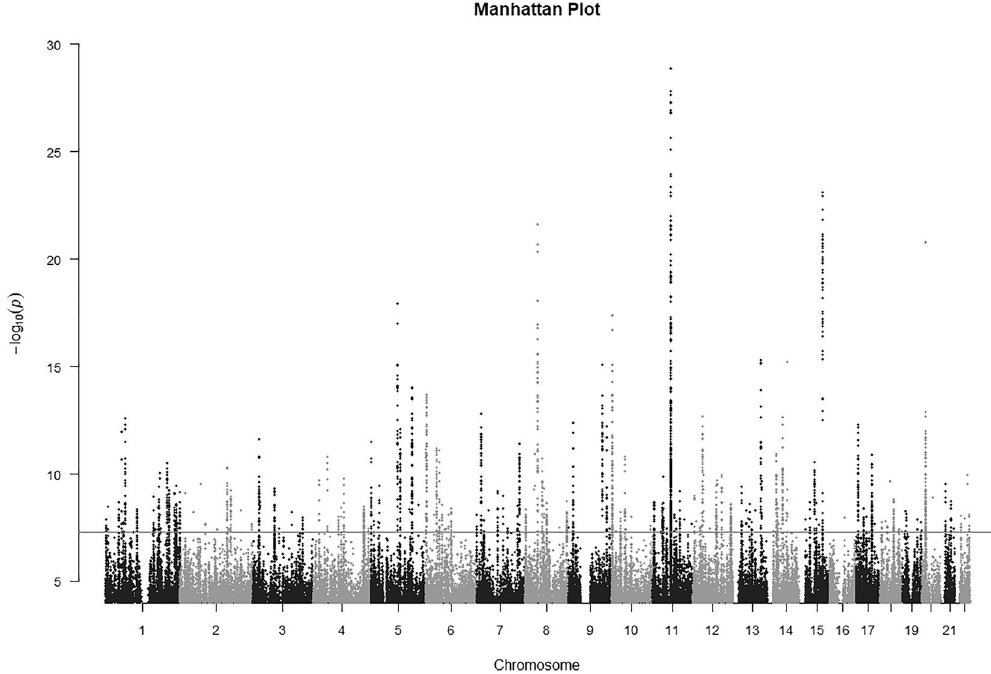
Figure 2. Manhattan plot showing results from GWAS of 437 lipid species results. The plot represents only the SNPs with nominal statistical significance ( p -value < 5 × 10 −4 ). SNPs above the red line represents those with p -value < 5 × 10 −8